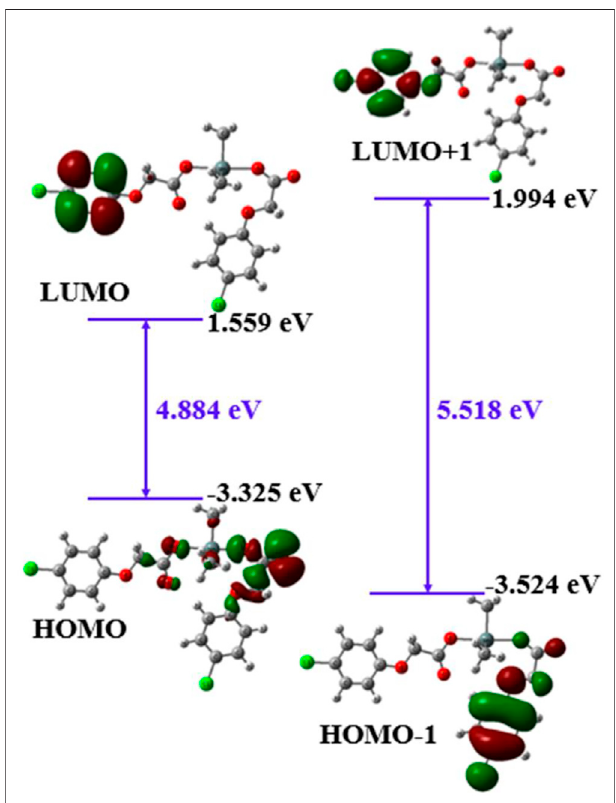
FIGURE 4 | The FMOs of complex 4 determined at B3LYP/6-31G* + LANL2DZ method.